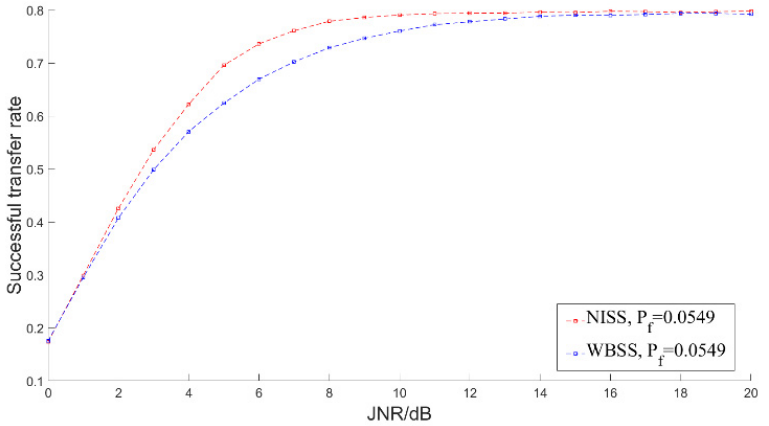
Figure 9. Variation diagram of decision accuracy with JNR of two anti-intelligent blocking algorithms. Figure 10 is a channel decision diagram of the WBSS algorithm against intelligent blocking jamming. The vertical coordinate indicates the channel serial number, the horizon- tal coordinate indicates the current communication slot. The green area indicates that the current channel is predicted to be jammed, but there is no jamming in the actual channel. The light red area indicates that the current channel is jammed but was not predicted. The dark red area indicates that the current channel has jamming and was successfully predicted. For the WBSS algorithm, when the algorithm converges, some channels will be jammed, but the agent was not successfully predicted. If the channel is selected for communication at this time, the communication will fail and cause great